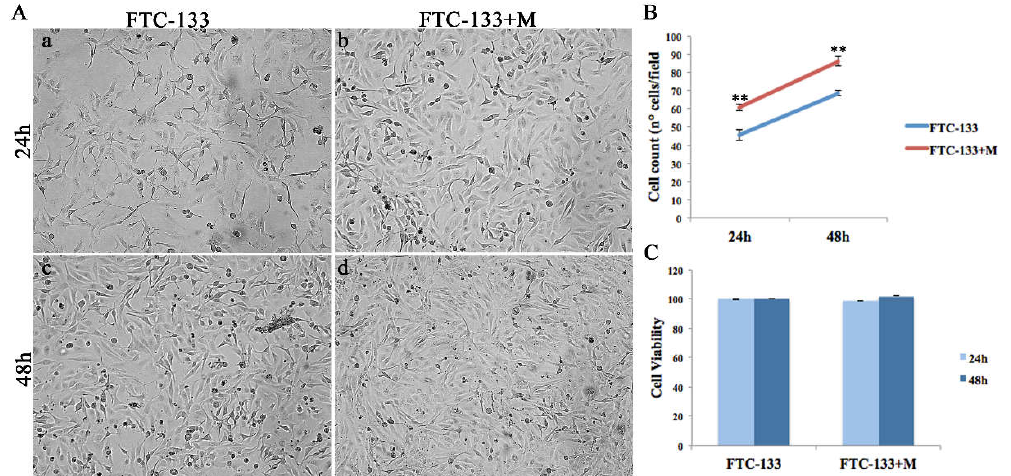
Figure 3. MiR-19a mimic overexpression effects on FTC-133 morphology, proliferation and cell viability. ( A ) Morphological analysis of control ( a , c ) and miR-19a mimic overexpressing ( b , d ) FTC-133 cells, at 24 and 48 h post-transfection. ( B ) Cell count of control cells (blue) and miR-19a mimic overexpressing cells (red), 24 and 48 h after overexpression. Student t -test p value ( p < 0.0001) indicates significant differences between miR-19a mimic transfected groups and control samples. ( C ) MTT assay assessed on FTC-133 and FTC-133+M, 24 and 48 h post-transfection.